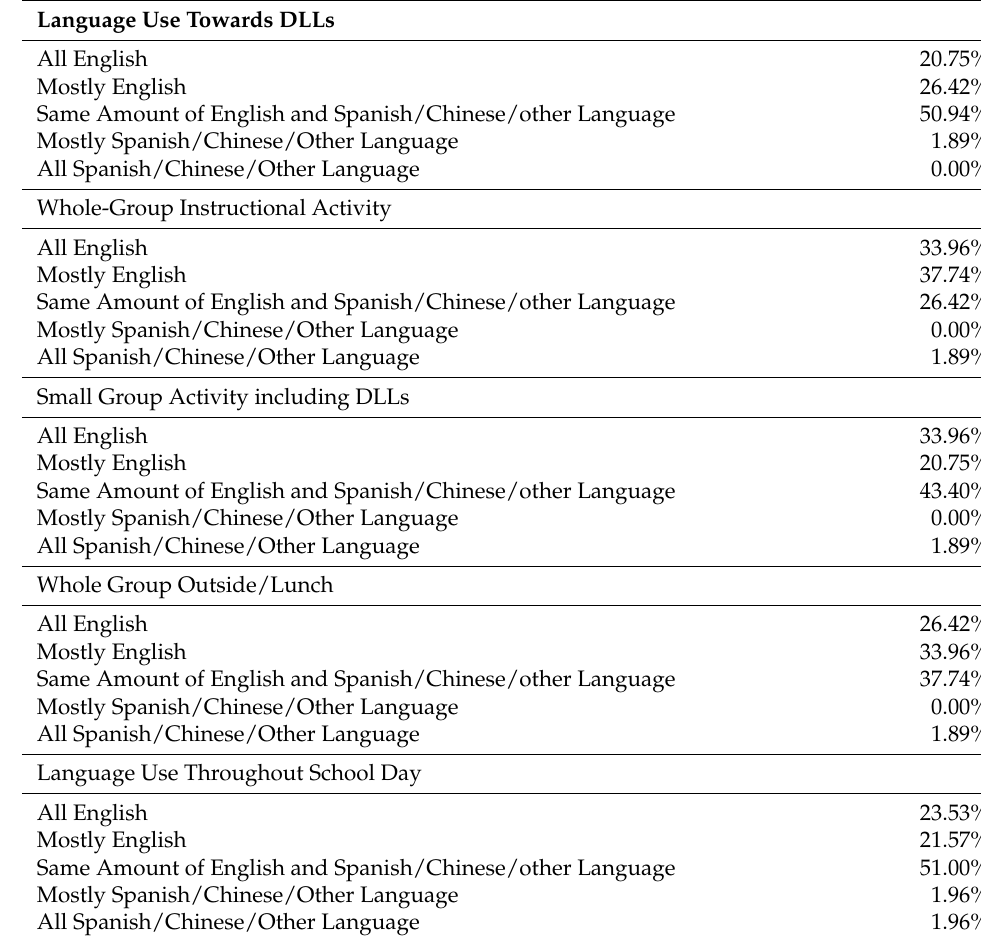
Table 3. Frequency of teachers’ language use in the classroom ( N = 53).